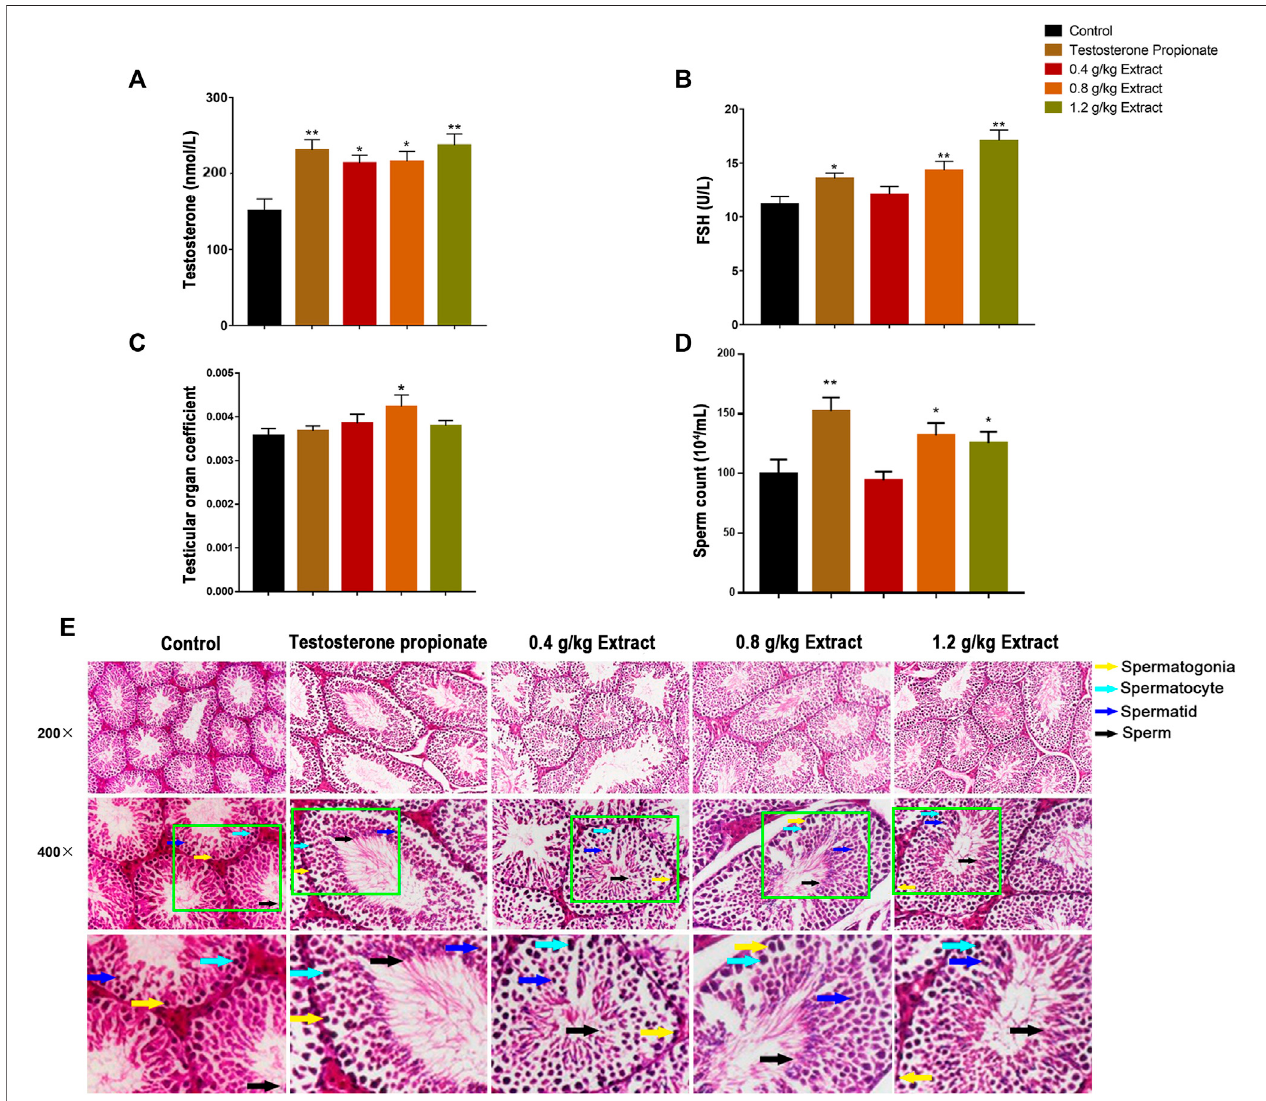
FIGURE 1 | The effects of EF extracts on spermatogenesis in mice (Control: water; Testosterone Proplonate: 5 mg/kg; Extracts: 0.4, 0.8, 1.2 g/kg). (A) The concentration of serum testosterone was analysed by ELISA. (B) The concentration of serum FSH was analysed by ELISA. (C) Testicular organ coef fi cient analysis of testes. (D) Thespermcountanalysisofepididymis. (E) Haematoxylinandeosin(HE)staininganalysisoftestestreatedwithdifferentdosesofEFEE.Valuesareexpressed as the mean ± SD ( n = 10).* p < 0.05, ** p < 0.01 vs control.